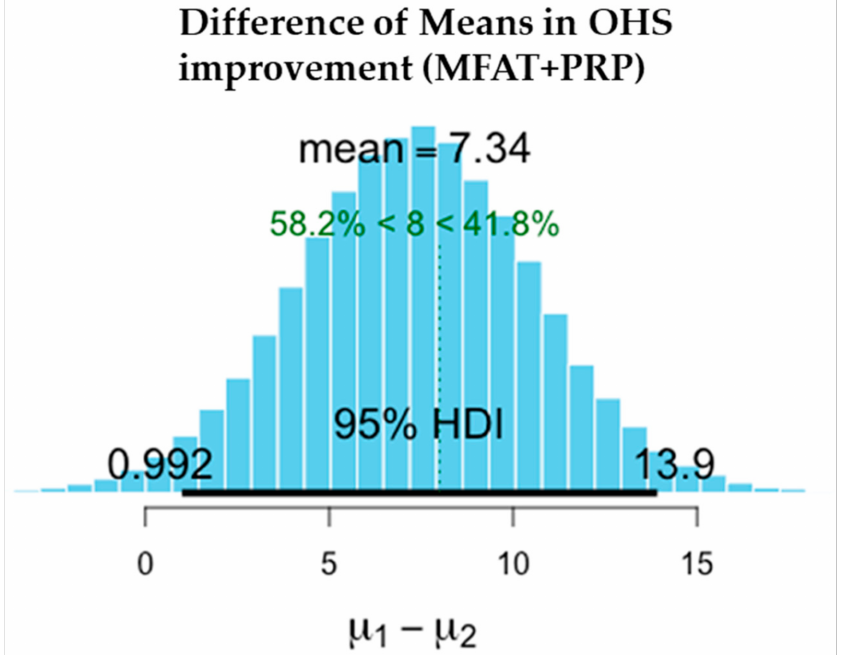
Figure 9. Demonstrates the difference of the means between the pre-treatment ( µ 2 ) and 1 year post treatment ( µ 1 ) OHS for MFAT + PRP. This shows the 95% credible interval between +0.993 and +13.920. The super-responder threshold of 8 is marked the dotted green